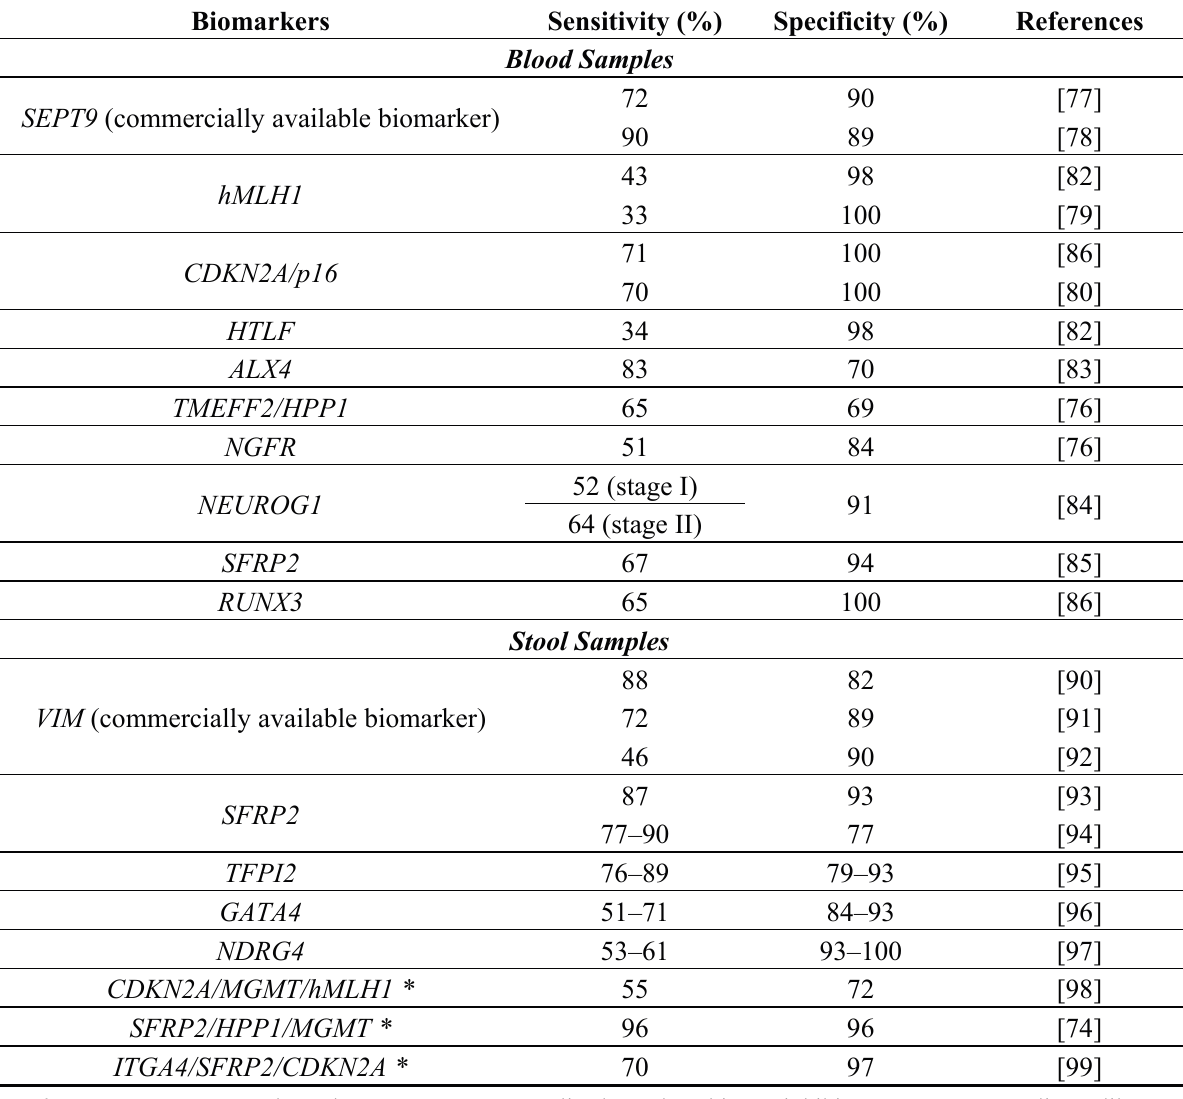
Table 1. DNA methylation biomarkers in blood and stool samples of colorectal cancer